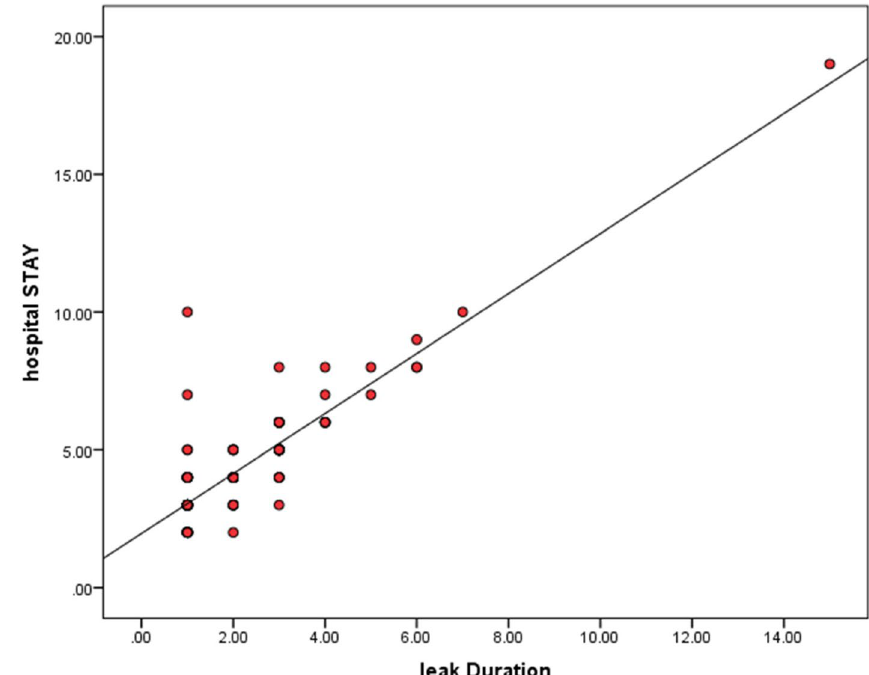
Fig. 3 Relationship among postoperative leak duration & hospital stay